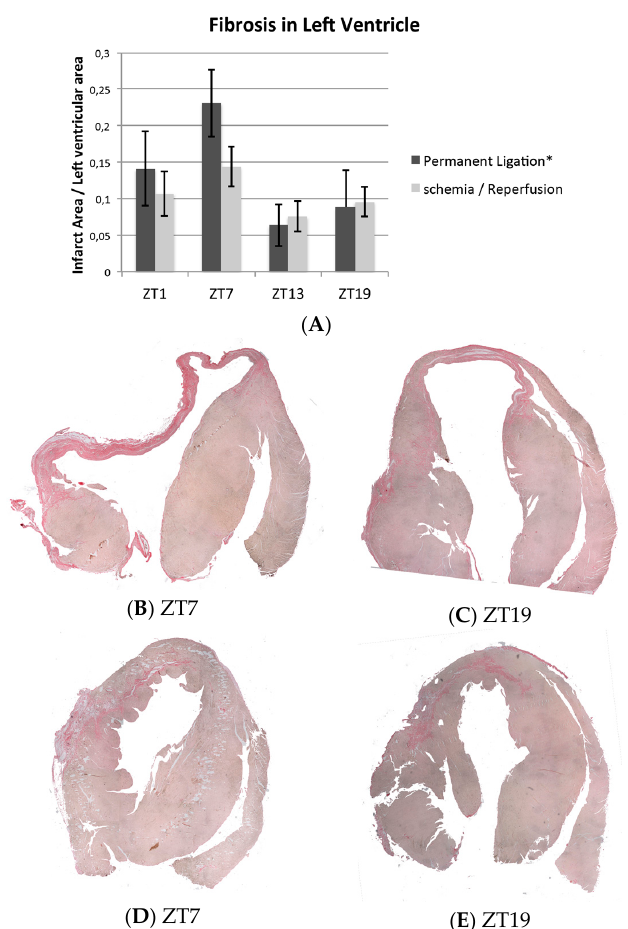
Figure 4. Picosirius-red staining of myocardial infarcts. The pink tissue represents fibrosis. ( A ) Fibrosis quantification; a 24-h rhythm in amount of fibrosis, based on the time of coronary artery ligation was present in PL but not IR. n = 20, 18, and 14 for PL, IR, and sham respectively, n = 3–5 per time point; ( B – C ) representative examples of permanent ligation. Infarcts induced at ZT7 ( B , middle of inactive/resting period) were larger compared to infarcts induced at ZT19 ( C , middle of the active period); ( D – E ) representative examples of Ischemia/reperfusion. No differences were found between time points. * Indicates p < 0.05 for 24-h rhythm. ZT: Zeitgeber Time (ZT0 = lights on).